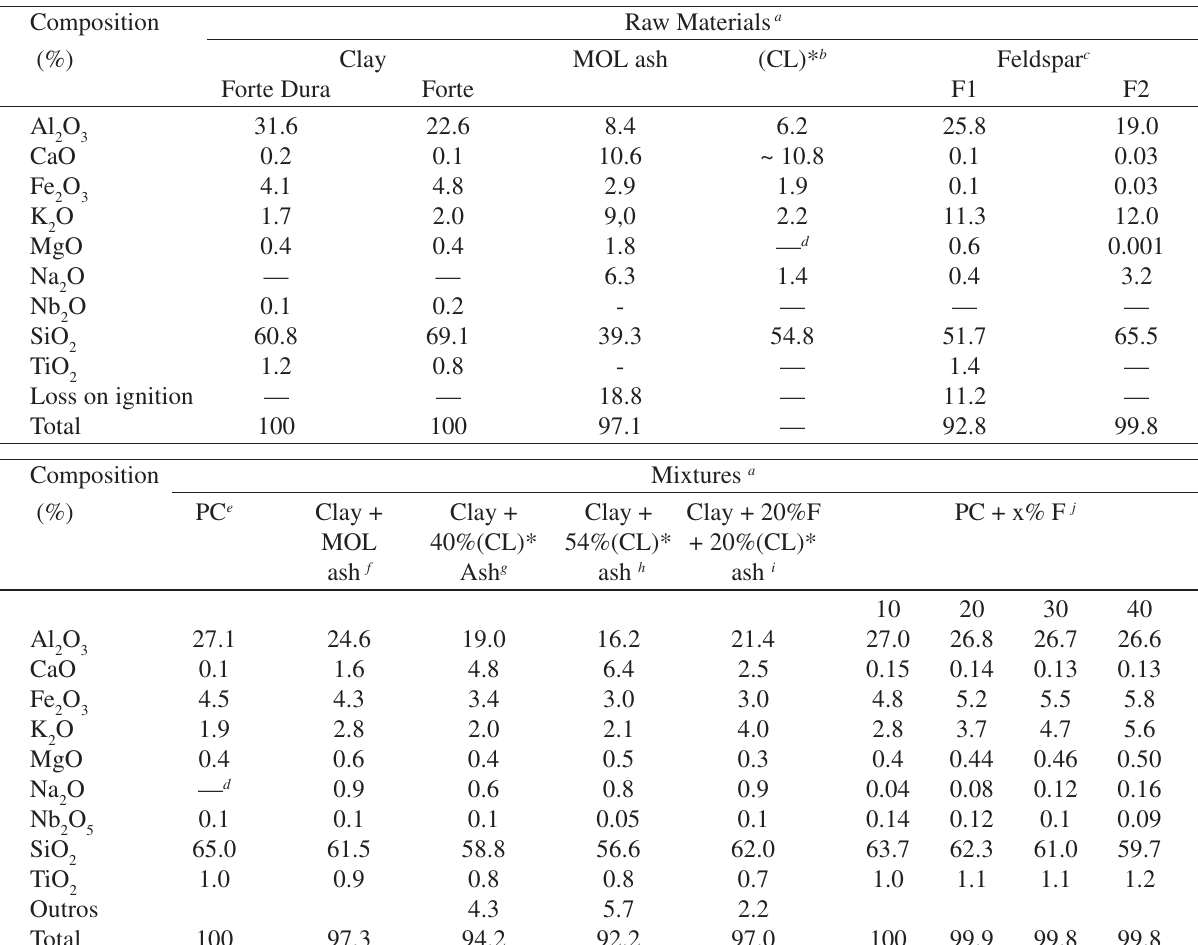
Table 2. Chemical composition of the raw materials and ceramic mixtures.